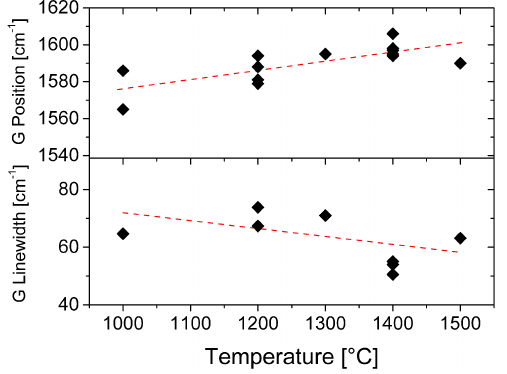
Figure 2. G position and linewidth as a function of sample prepa- ration